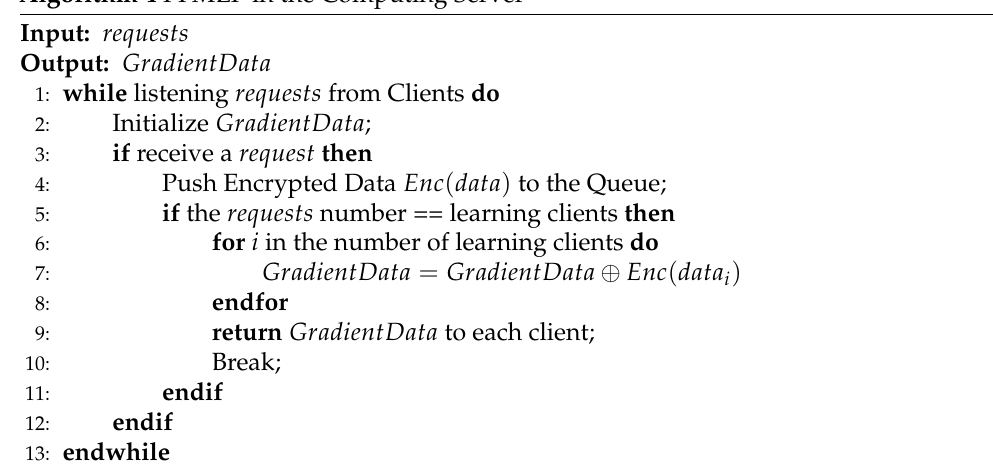
Algorithm 4 PFMLP in the Computing